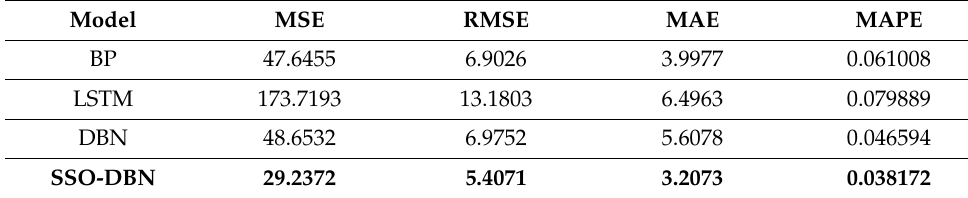
Figure 12. PV power prediction results of different methods. Table 5. Prediction results evaluation form (PV